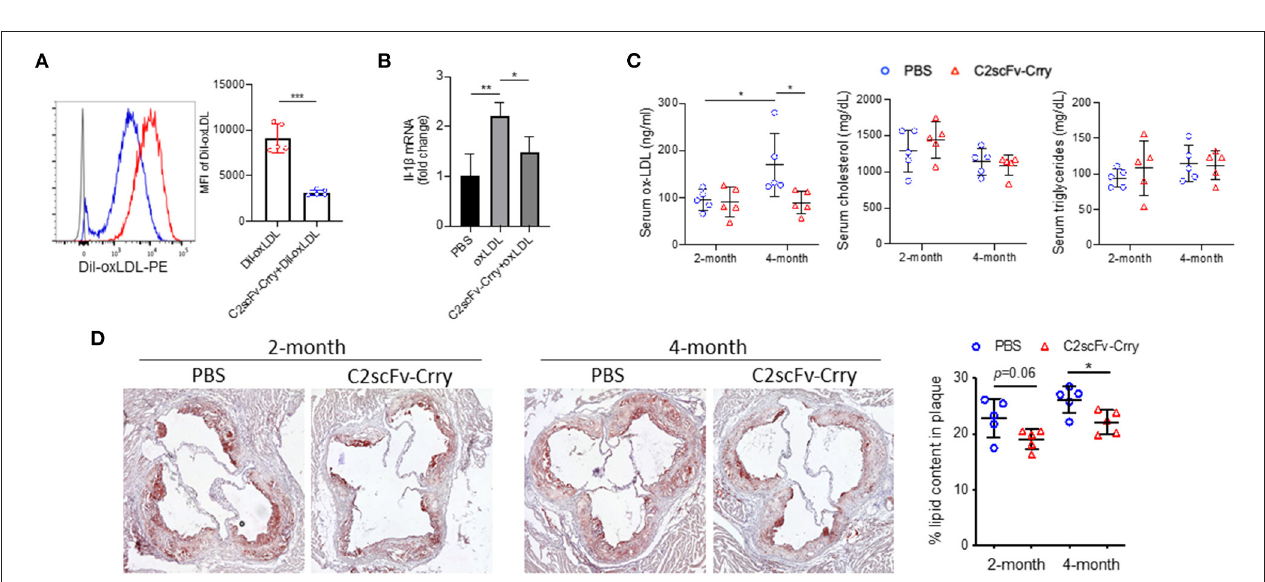
FIGURE 4 | C2scFv-Crry inhibits oxidized low-density-lipoprotein uptake by macrophage and lipid deposition in the plaque. (A) Dil-labelled oxidized low-density lipoprotein (Dil-oxLDL) (50 ug/ml) was pre-incubated with PBS or 20 ug/ml C2scFv-Crry for 30min, followed by incubation with peritoneal macrophage for 16h. The uptake of Dil-oxLDL was determined by the intensity of Dil in macrophages. Left: Representative histogram of Dil. Right: Mean fluorescence intensity (MFI) of Dil. (B) IL-1ß mRNA level in peritoneal macrophage treated with pbs, oxLDL or oxLDL + C2scFv-Crry for 24h. (C) Serum oxLDL, cholesterol and triglyceride levels in Apoe − / − mice treated with PBS or C2scFv-Crry. (D) Representative image and quantification of Oil Red O staining in aortic root of Apoe − / − mice treated with PBS or C2scFv-Crry (* p < 0.05, ** p < 0.01, *** p < 0.005 using unpaired Student’s t -test). and binds to oxidized phospholipids, blocks the uptake of oxLDL by macrophages and reduces vascular inflammation